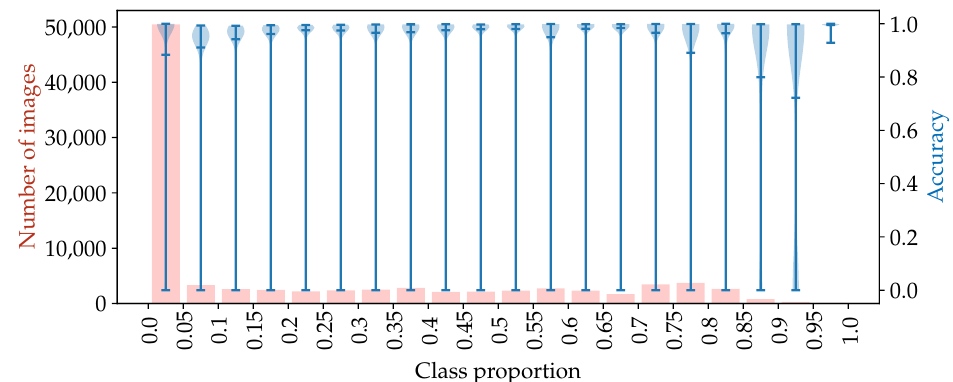
Figure 7. Accuracy (violin plot with mean value, blue) and number of images (histogram, red) over the class proportion regarding all tested image patches. The data depict the application of the small-scale network in 30 iterations on the test datasets. All predicted image patches were analyzed separately (not gathered in batches or overview images). It can be observed that the mean accuracy significantly decreases for low (approx. < 0.20) and high (approx. > 0.70) class